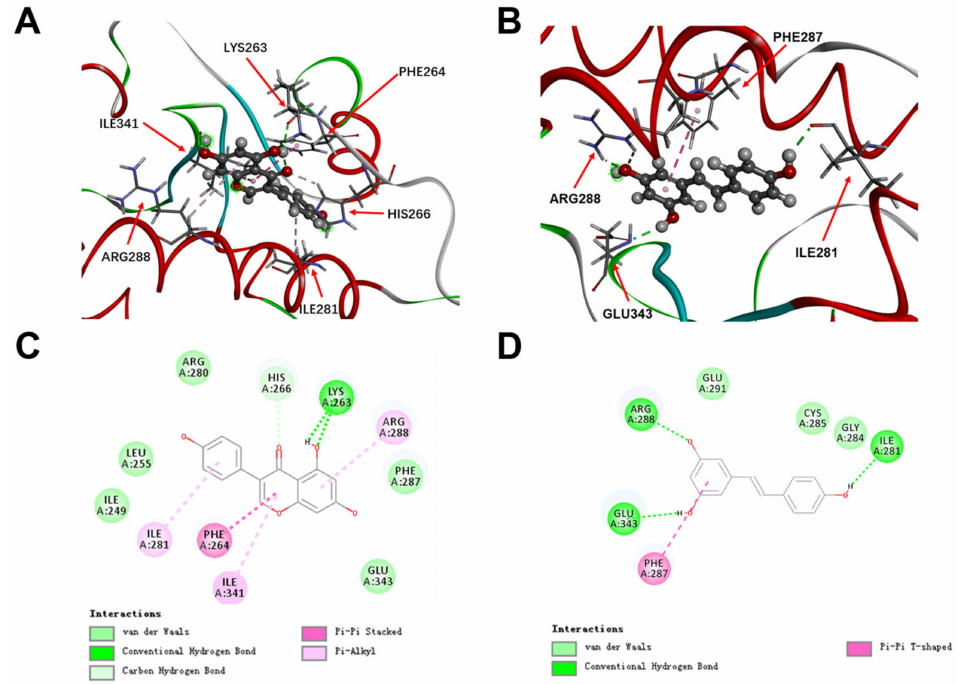
Figure 4. The docking patterns of genistein and trans-resveratrol interact with PPAR γ in the active site of PPAR γ illustrated by CDOCKER. 3D presentation of interaction between genistein ( A ) or trans-resveratrol ( B ) and PPAR γ . 2D presentation of interaction between genistein ( C ) or trans-resveratrol ( D ) and PPAR γ . The red arrows refer to the amino acid residues that interact with genistein and tran-resveratrol in the binding site of PPAR γ . Table 3. The CDOCKER analysis results of genistein and trans-resveratrol at the active site of PPAR γ .